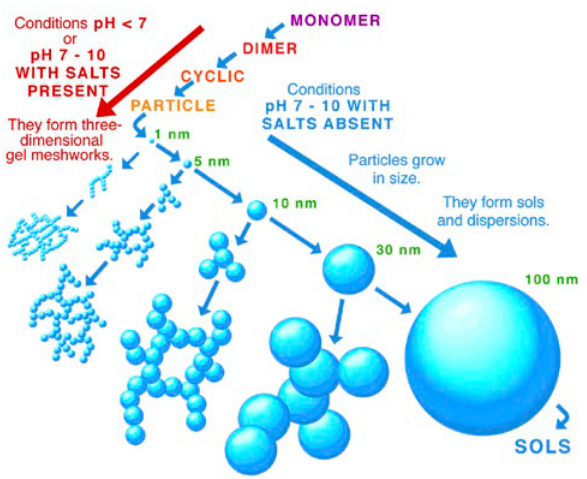
Figure 47. This diagrammatic representation of the growth of natu- ral silica particles is re-drawn from Iler 8 , 1979, p. 174.